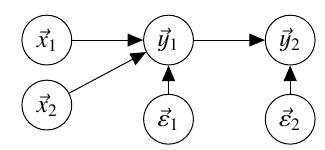
Figure 1. Simple Bayesian